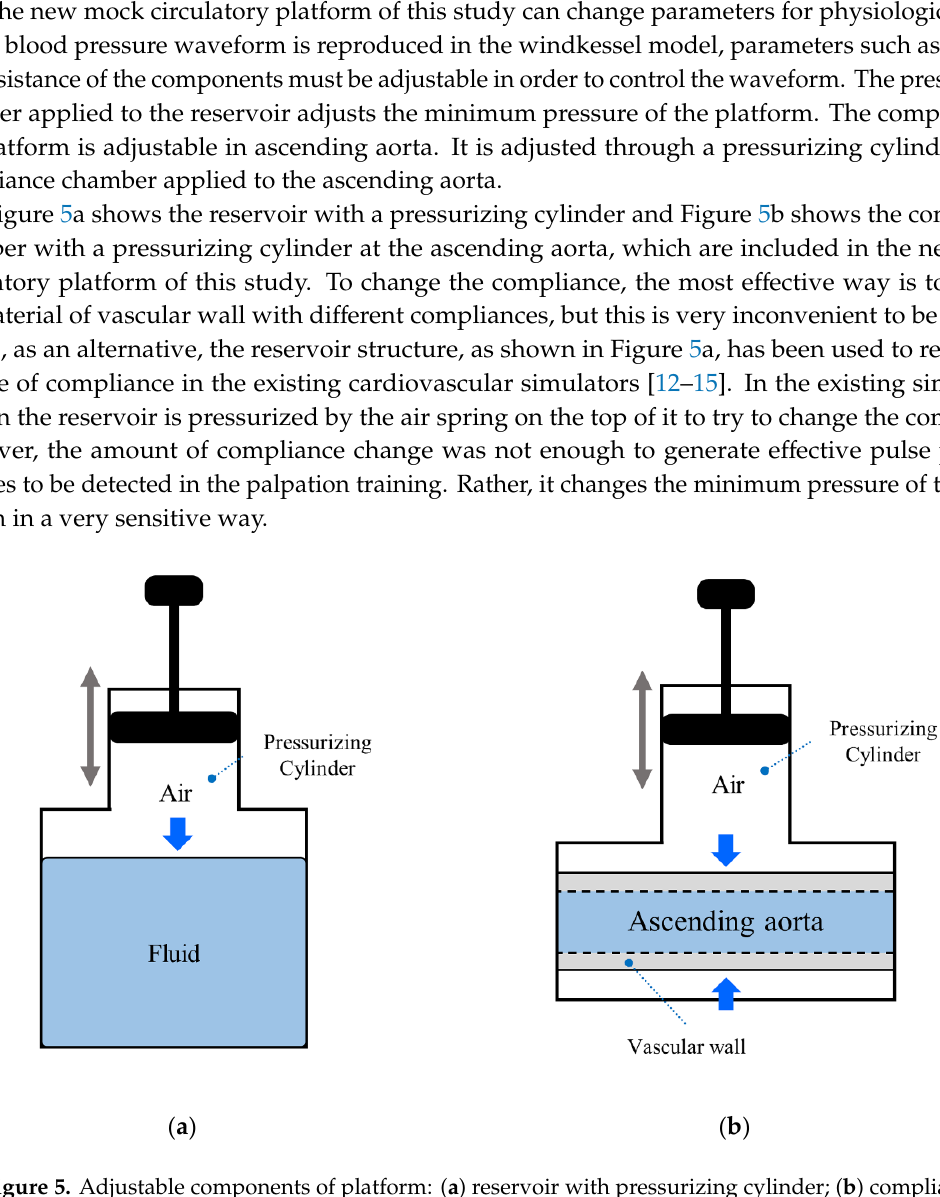
Figure 5. Adjustable components of platform: ( a ) reservoir with pressurizing cylinder; ( b ) compliance chamber with pressurizing cylinder.